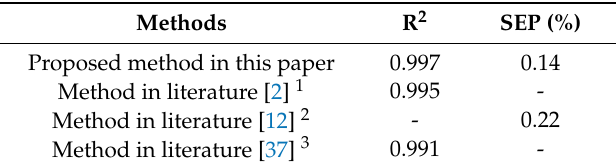
Table 3. The accuracy of the moisture content of wheat measured by the proposed method versus methods of literature.